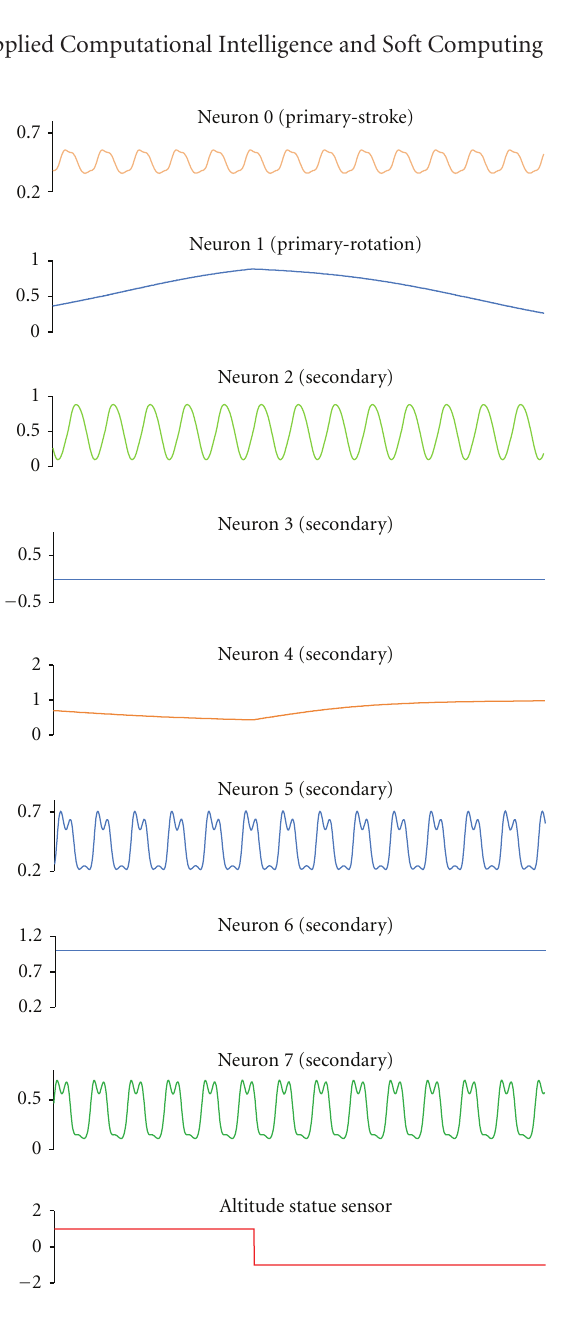
Figure 23: The above figure shows the neuron output state dynam- ics of each neuron in the fully connected original eight-neuron controller and the external altitude sensor, produced during the flight control of the MFWR to provide optimal cruise behavior. It can be observed that the output states of neurons 1 and 4 entrain with altitude sensor in phase and out of phase, respectively.